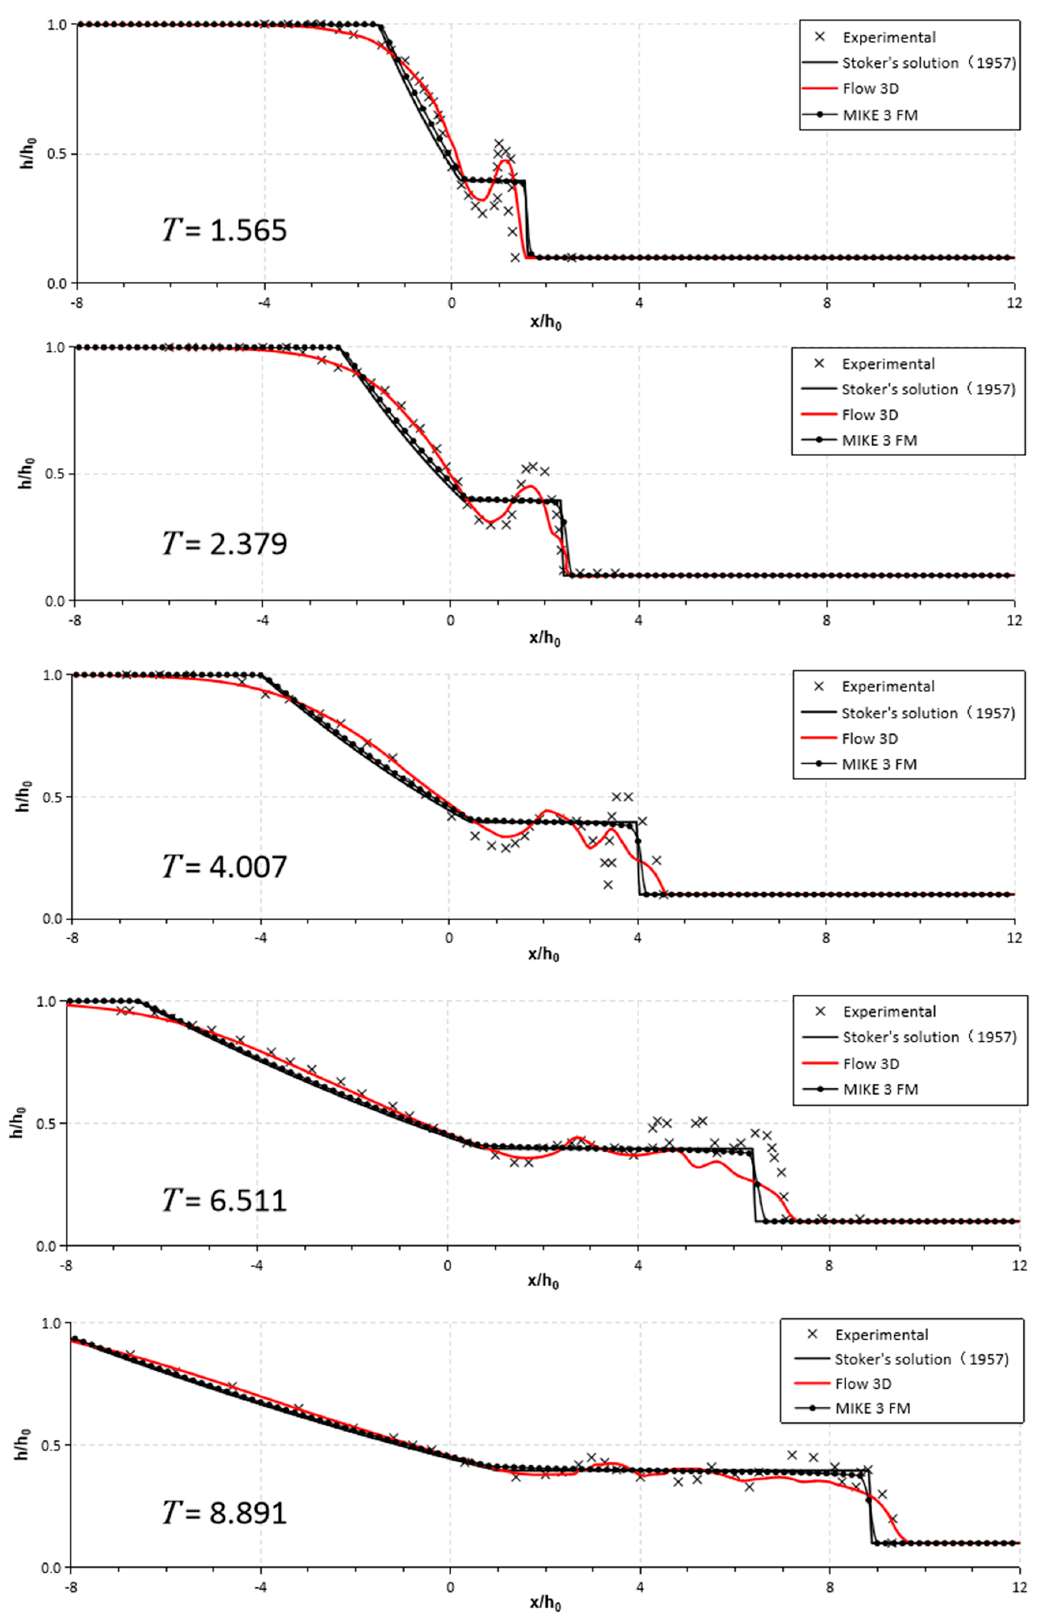
Figure 7. Comparison between observed and simulated free surface profiles at dimensionless times T = t ( g / h 0 ) 1/2 and for a wet-bed ( α = 0.1). The experimental data are from Reference [30].